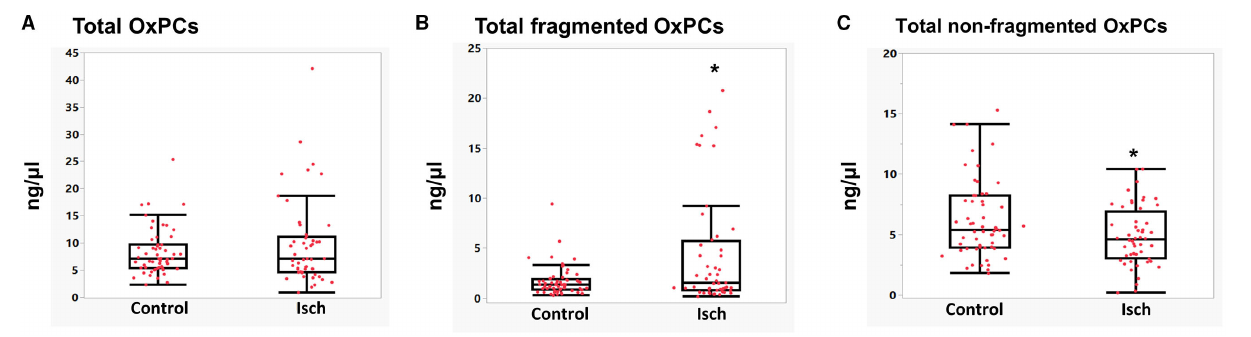
FIGURE 3 | Levels of total OxPCs (A) , fragmented (B) , and non-fragmented OxPC (C) in STEMI patient during ischemia and controls. *Significant differences compared with controls, P < 0.05.